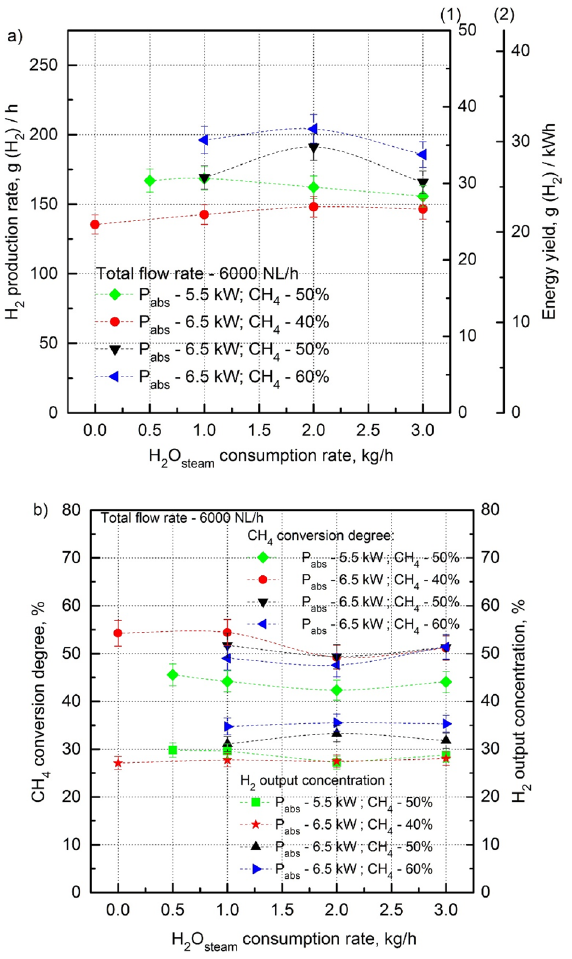
Figure 6. H 2 production rate, energy yield ( a ), CH 4 conversion degree and H 2 output concentration ( b ) as a function of the